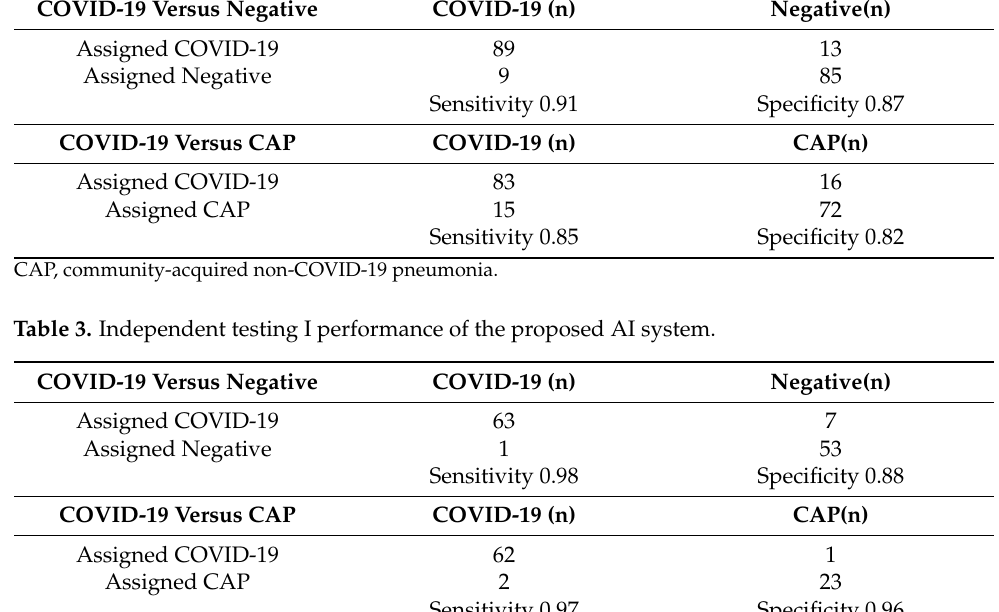
Table 2. Training and validation (cross-validation) performance of the proposed AI system. COVID-19 Versus Negative